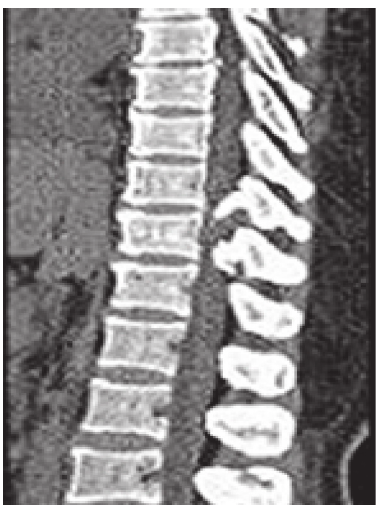
Figure 3: CT thoracic spine shows T10-T11 vertebral body and disc